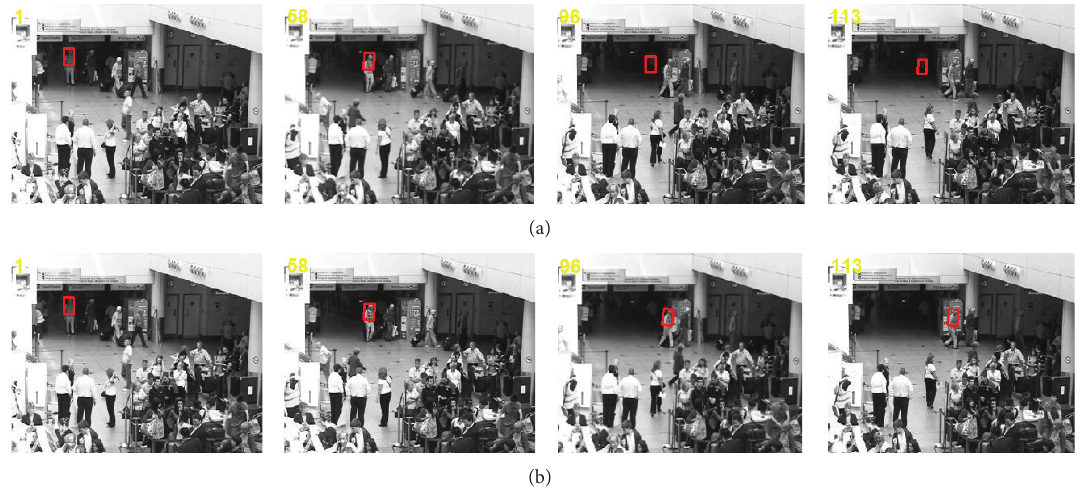
Figure 11: Tracking results for seq.5. The first row: results for IVT. The second row: results for our method.